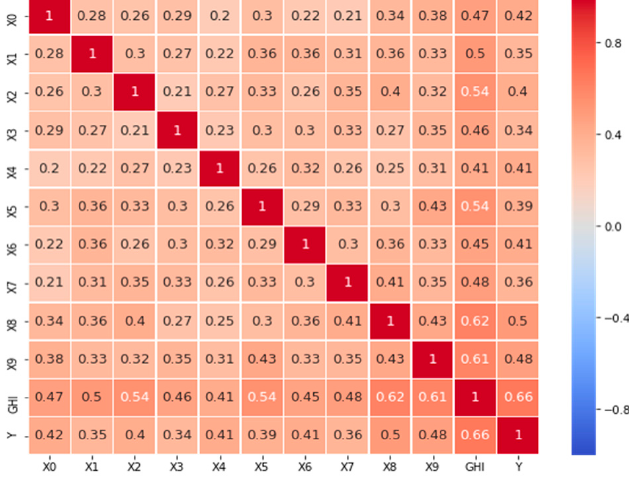
Figure 2. Pearson correlation between input and output.